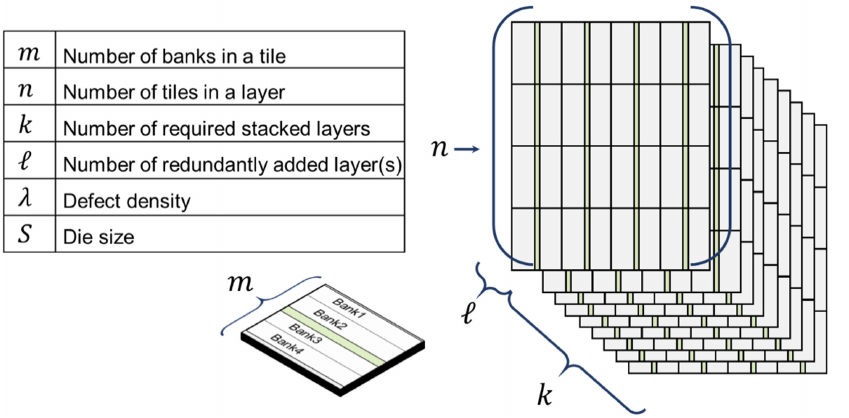
Figure 51. BBCube stack configuration and symbols for